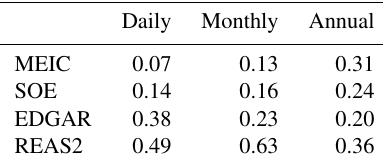
Table 2. The weighting factors ( w ) of each inventory in the en- semble predictions of PM 2 . 5 when using daily, monthly, and annual averages in the objective function (Eq.